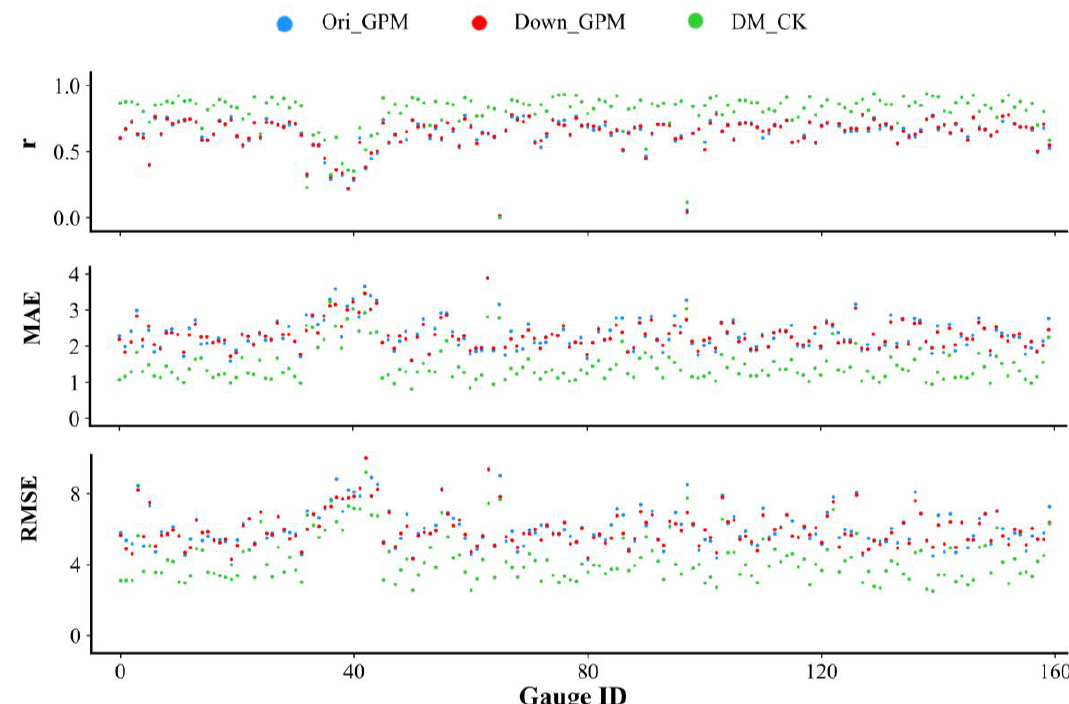
Figure 9. Evaluation for quantitative indices of the Ori_GPM, Down_GPM, and DM_CK for daily precipitation estimates at gauge positions from March 2016 to February 2018.